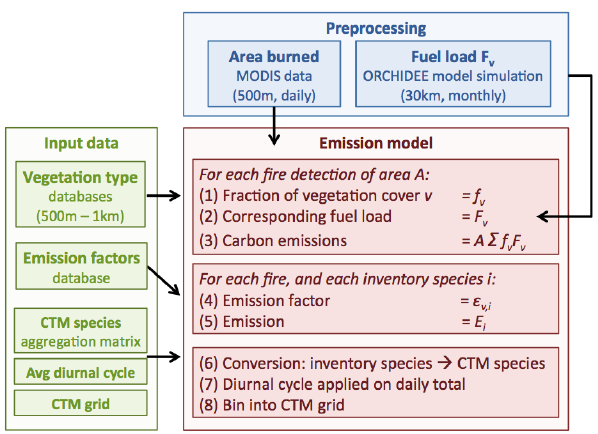
Fig. 7. Schematic representation of the APIFLAME emissions’ model.